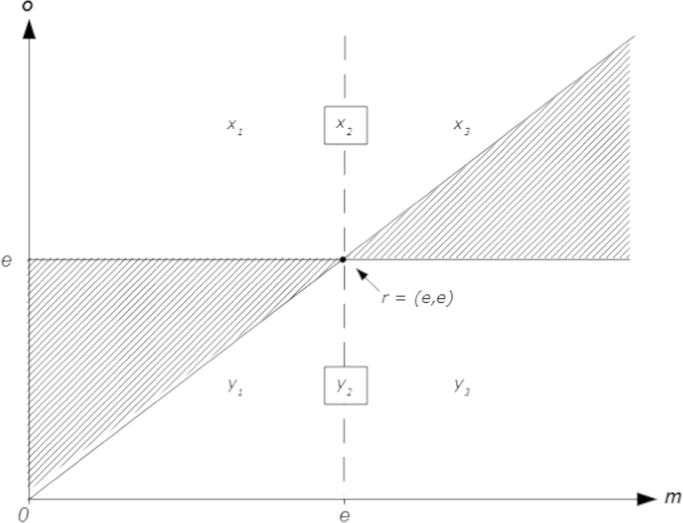
Delineation of archetypes of distributional preferences.